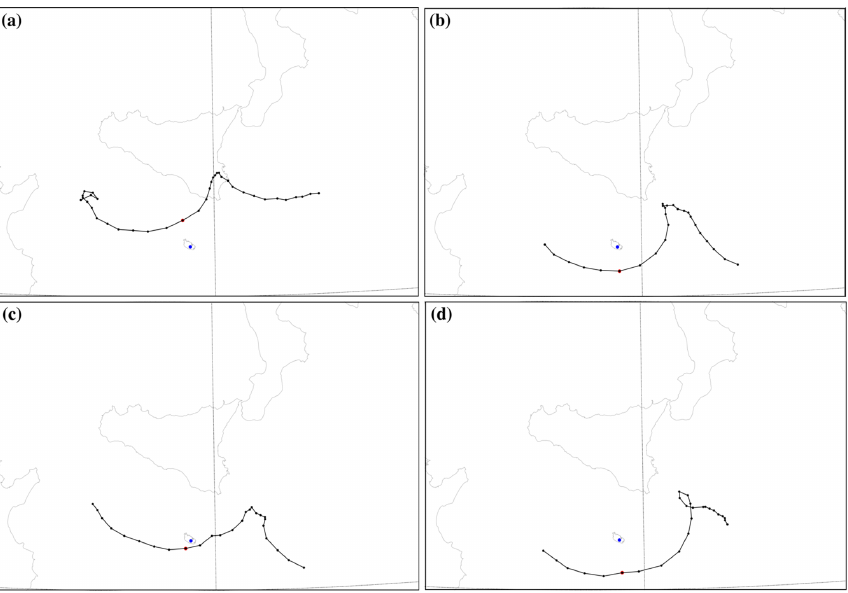
Figure 11. Best cyclone’s trajectory depicted by each experiment, (a) NODA, (b) SYN, (c) RSAMV and (d) CNTRL, from 11:00UTC, 7 November, to 12:00UTC, 8 November 2014.